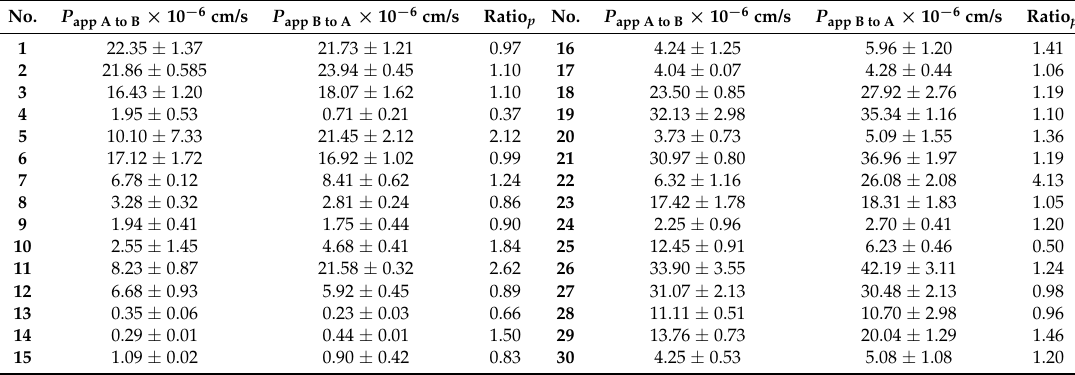
Table 3. Apparent permeability coefficients ( P app ) of flavonoids in Caco-2 monolayer.